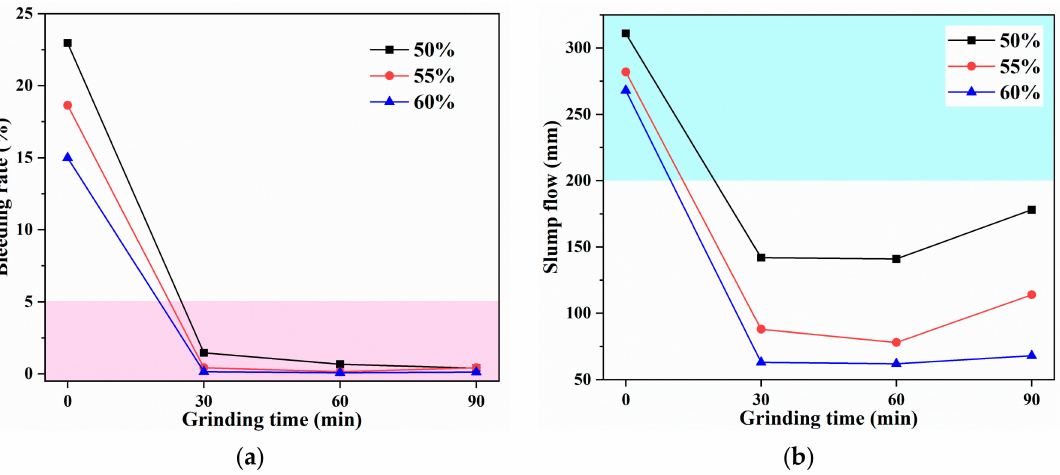
Figure 6. The ( a ) bleeding rate ( B w ) and ( b ) slump flow ( D f ) of GBM-A1 slurry using CG-A obtained by grinding without